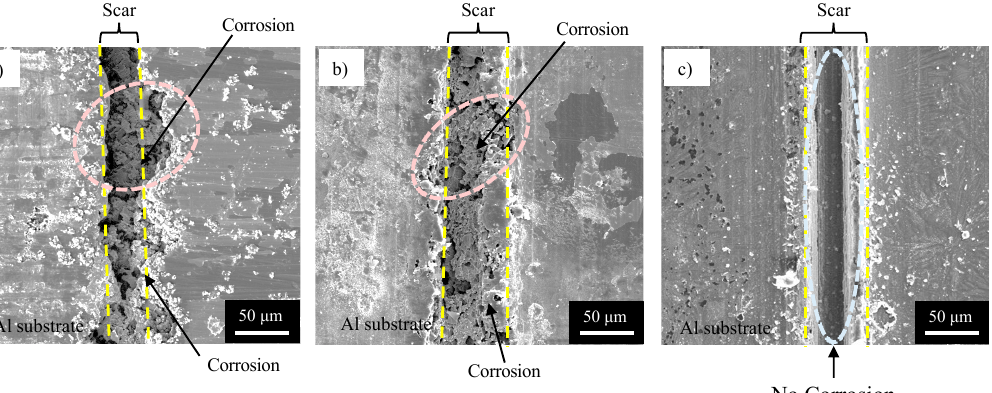
Figure 9. SEM images of the surface of specimens after corrosion test and immersion in coating remover and phosphoric acid/chromic acid solution, obtained for ( a ) NC, ( b ) SHC-SC, and ( c ) SHC-SFC.